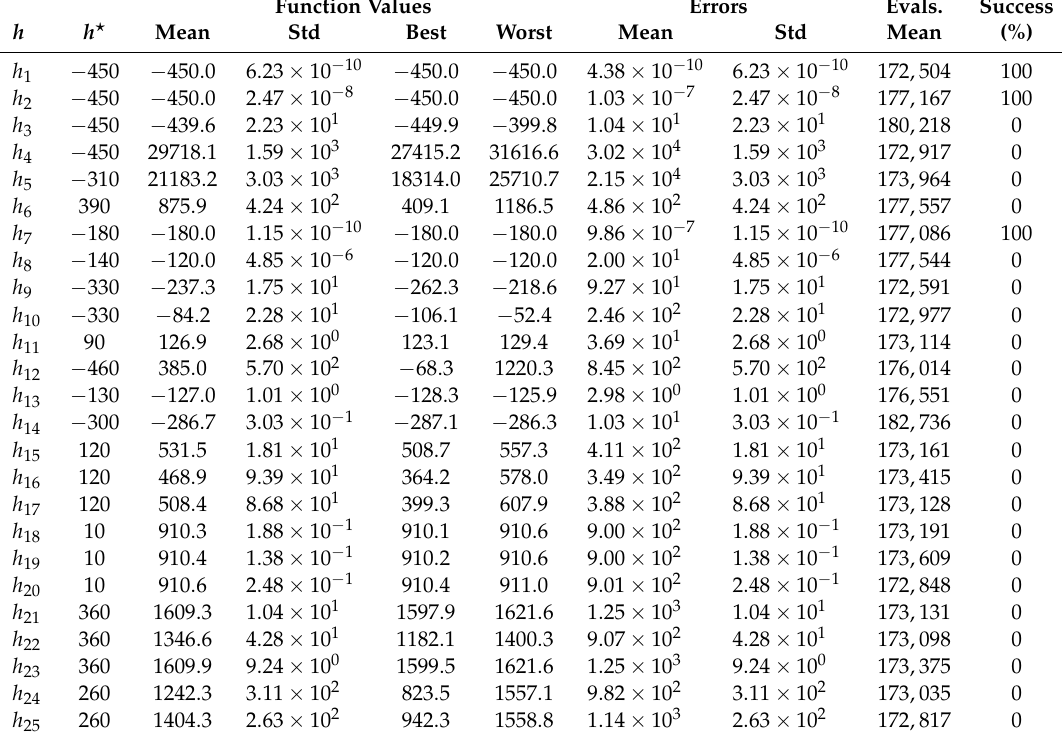
Table 8. The QCGA results of hard functions h 1 – h 25 with dimension n = 30. Function Values Errors Evals.